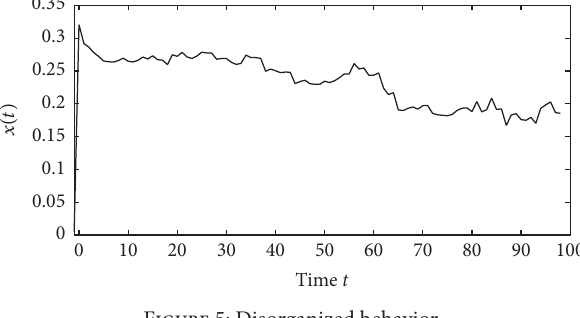
Figure 5: Disorganized behavior.